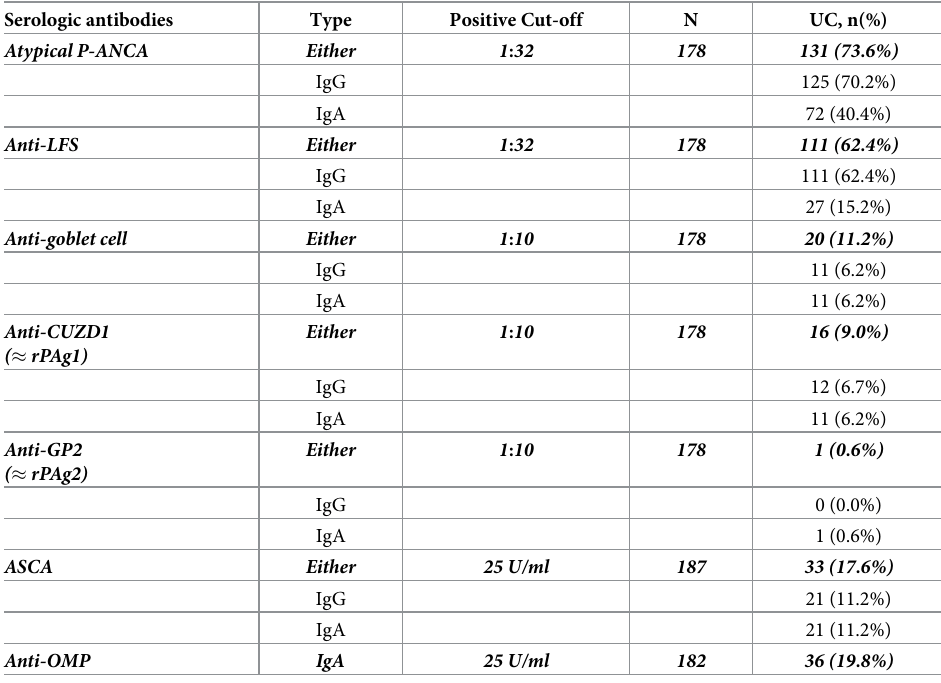
Table 2. Serologic antibodies in patients with ulcerative colitis (UC). Serologic antibodies